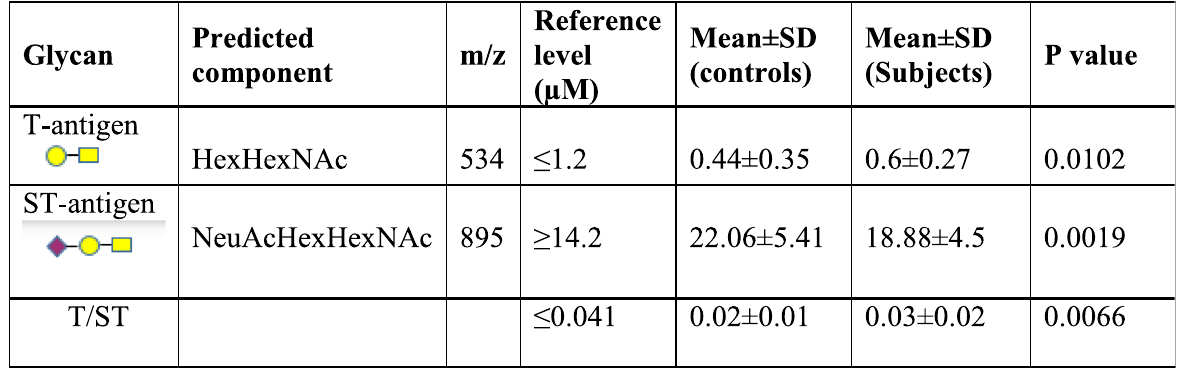
Table 3 O-glycan analysis using LC-MS/MS technique showing the 2 O-glycans measured for subjects and